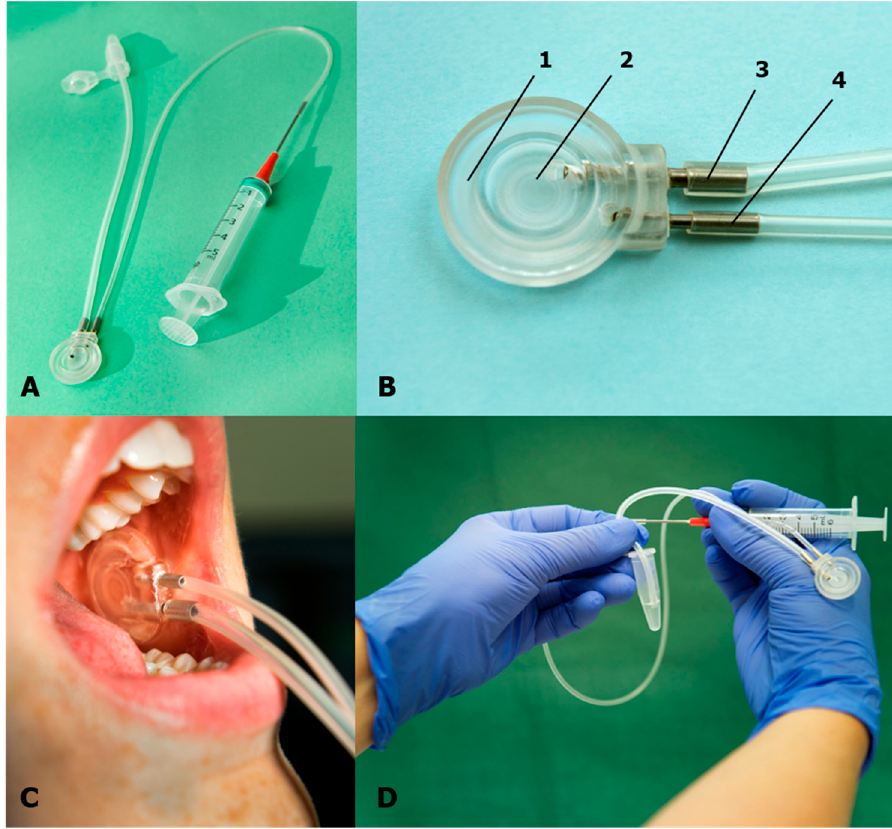
Figure 1. ( A ) Parotid saliva collection set up (cup, metal and silicone tubes, syringe, and cannula). ( B ) Parotid saliva cup collection device: 1: outer cup for fixation of the cup to the mucosa around the Stensen´s duct by vacuum; 2: inner cup inclosing the opening of the Stensen´s duct; 3: metal tube with silicone tubing and outlet tube for the saliva; and 4: tube for the production of a vacuum in cup. ( C ) Cup placed over the papilla of the Stensen´s duct for parotid saliva collection. ( D ) Saliva collected in an Eppendorf tube. Photo: S. Gustavsson, Redakta Reportage, Linköping, Sweden.